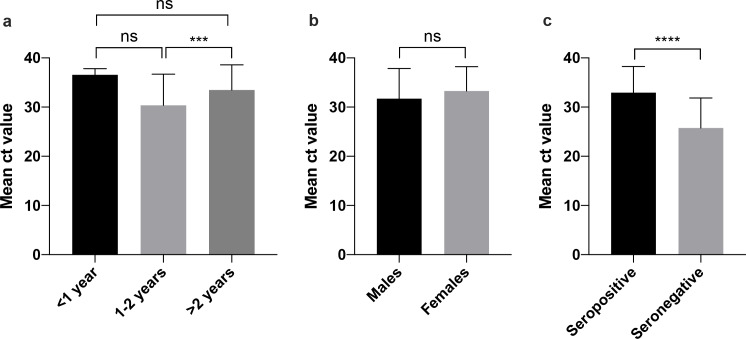
Comparison of MERS-CoV RNA load based on age, sex and presence of nAbs.One-way ANOVA with Bonferroni post-test was used for (a) and student’s t test was used in (b and c). ****p<0.0001, ***p <0.001 and NS denotes not statistically significant.